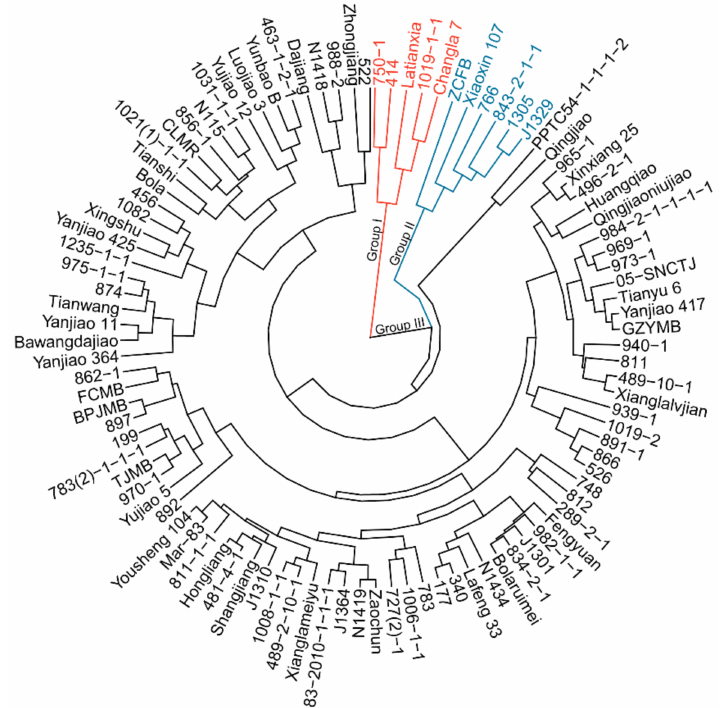
Figure 1. Cluster analysis of the low-nitrogen tolerance from 100 pepper cultivars.Cluster analysis was carried out based on the relative values of leaf area and shoot, root, and plant dry weights. Agglomerative hierarchical clustering was performed using the hclust algorithm in R, with dst = dist (dat1, method = “euclidean”) and hclust (dst, method = “average”). Group I, low-N-tolerant group; Group II, low-N-sensitive group; the low-nitrogen tolerance of Group III was between that of Groups I and